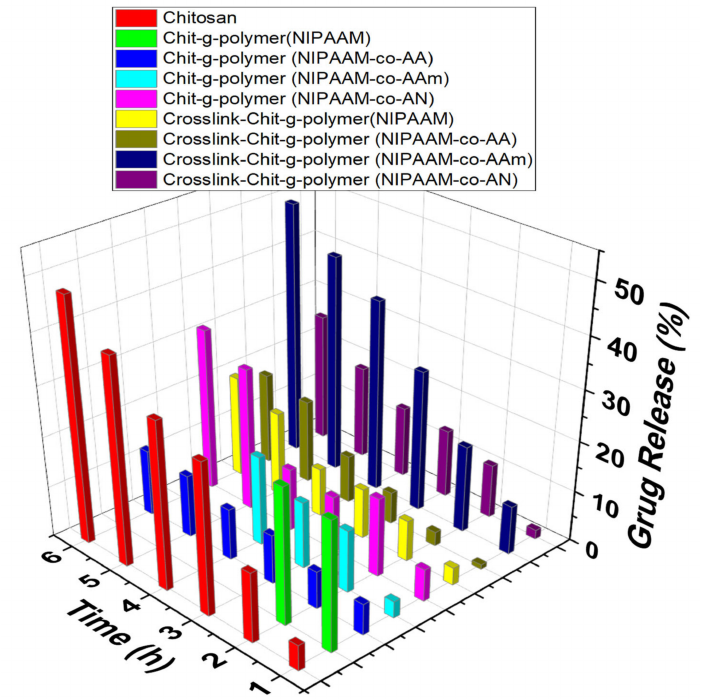
Figure 8. Drug Release performance of Grafted Copolymers and Crosslinked-graft Copolymers of NIPAAM and Binary Comonomers onto Chitosan. Polymeric taster = 25.00 mg, Concentration of DS solution for the drug laden = 100.00 µ g/mL, amount of buffer solution = 10.00 mL, pH of the solution =